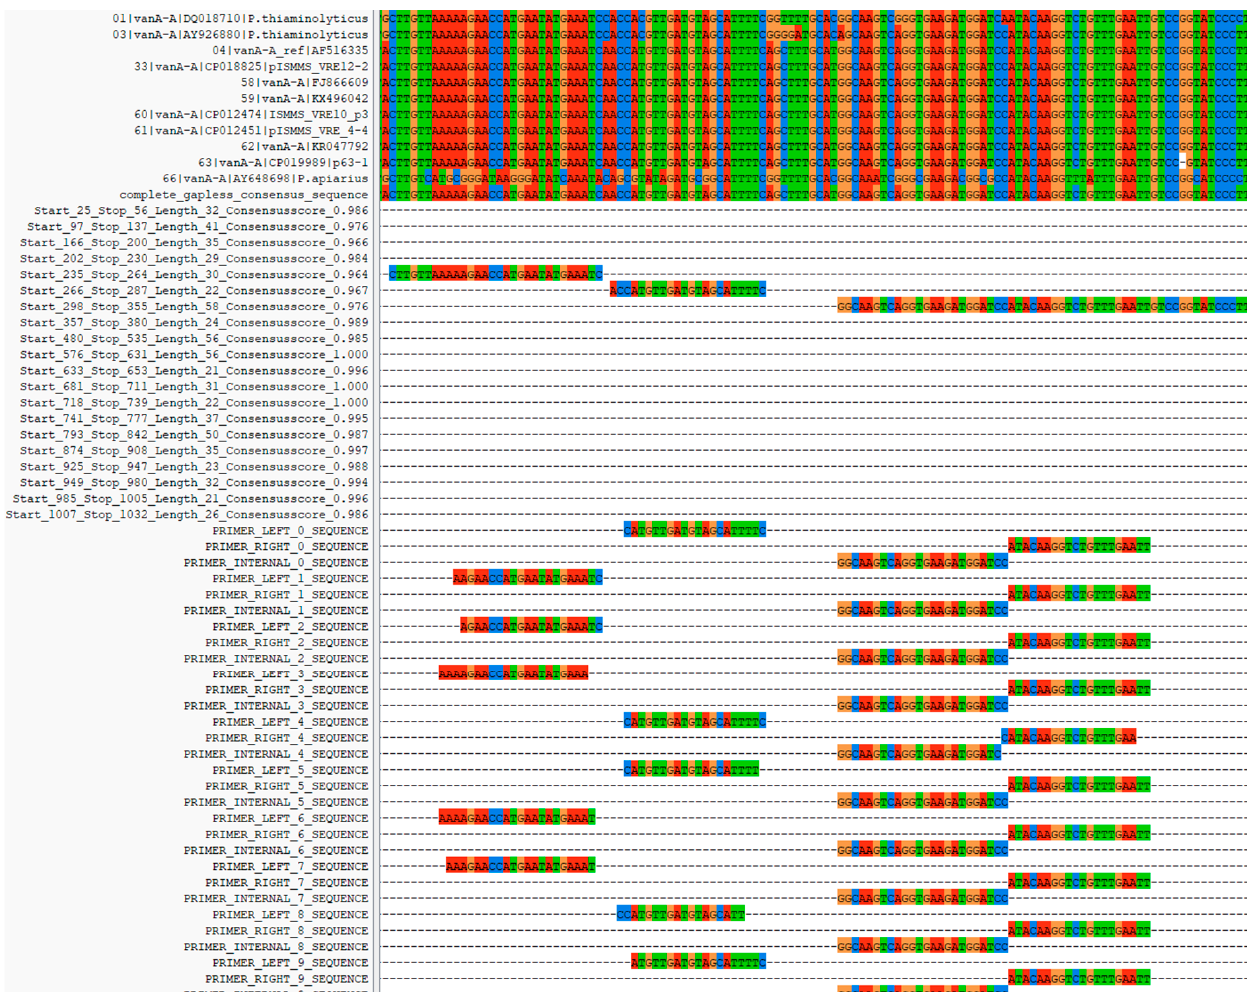
Figure 1. Final Alignment. Section of the final alignment visualized with ClustalX [10]. The vanA-A sequence of P. apiarius contains many nucleotides that deviate from the consensus sequence. In this case, the user must decide whether this sequence should remain in the alignment or remove it by adjusting the filter parameters.